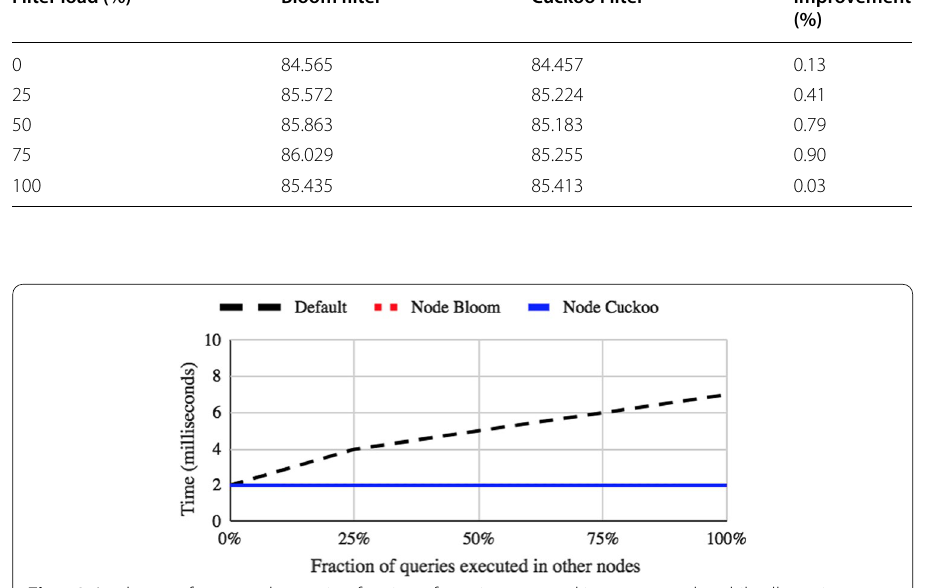
Fig. 10 Lookup performance by varying fraction of queries executed in remote node, while all queries executed locally or remotely returns negative results (lower is better). The performances of Node Bloom and Node Cuckoo are very similar and hence